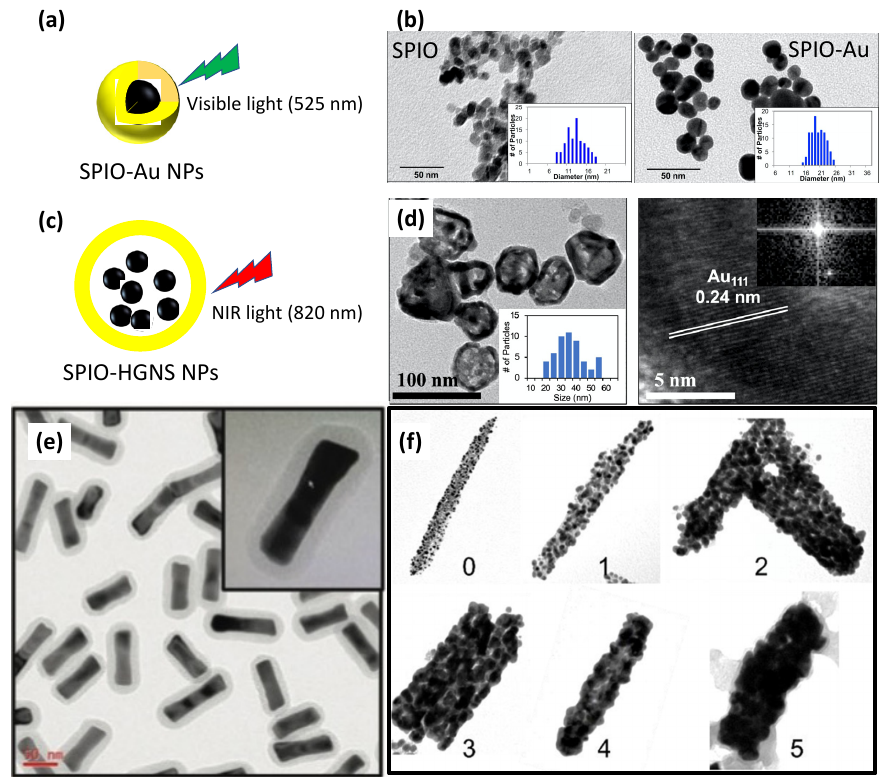
Figure 2. ( a ) Schematic of SPIO–Au-NP structure enabling 525 nm light stimulation. ( b ) TEM images